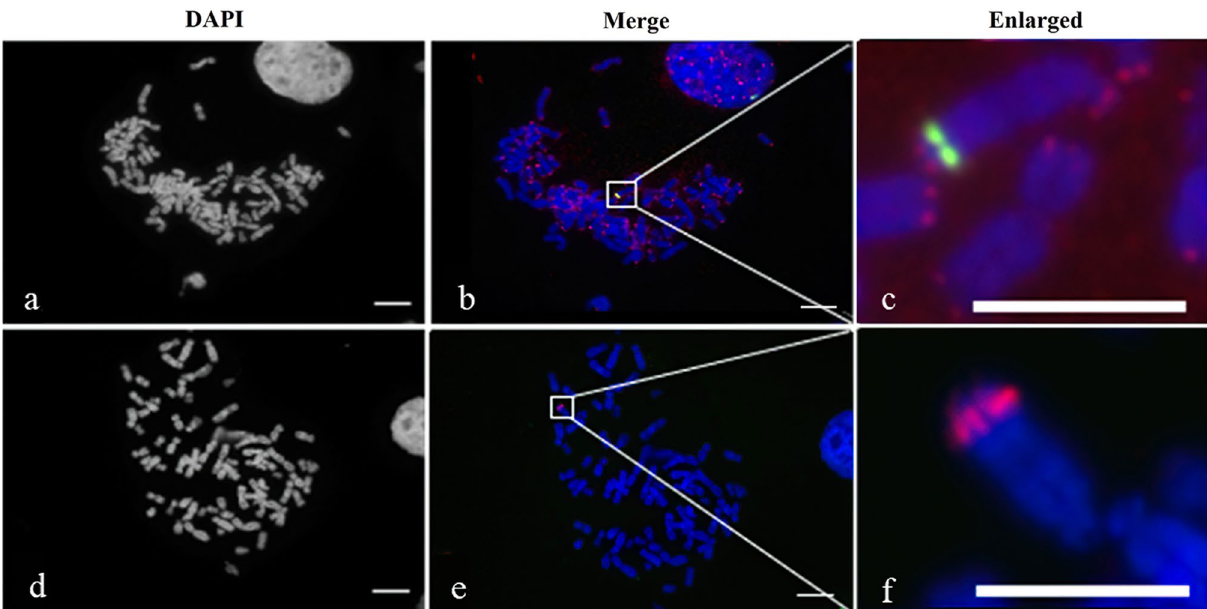
Figure 3. Genomic distribution of DNA repeats in the 300-day hybrid cell line. Fluorescence in situ hybridization (FISH) was done on mitotic metaphase plates using probes for Arabidopsis centromere (Atcen, green) and human telomere (red) ( a–c ), and the Atcen (red) and Arabidopsis telomere (green) ( d–f ). Chromosomes were counterstained using DAPI (gray pseudocolor in a , d and blue in b , c , e , f ). Scale bars, 10 µm ( a , b , d , e ) and 5 µm ( c , f